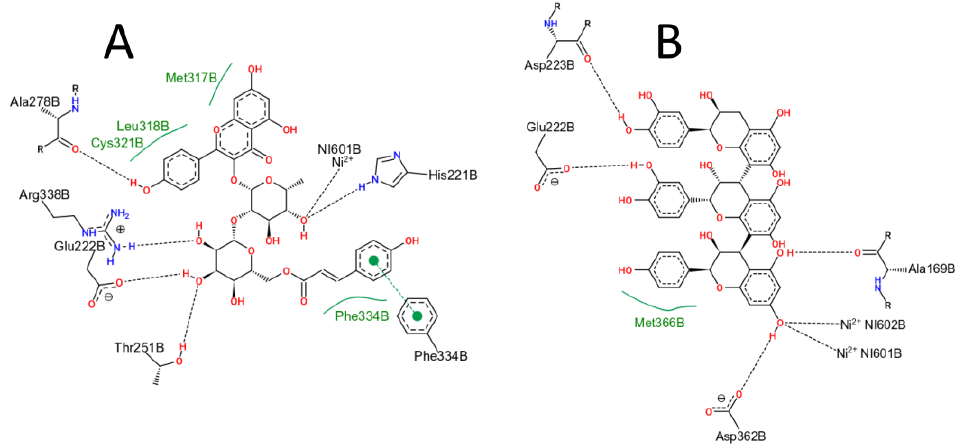
Figure 4. Intermolecular interactions between ligands Kaempferol-3-galactoside-6-rhamnoside-3- rhamnoside, CID44258967 ( A ) and (epi)afzelechin-(epi)catechin-(epi)catechin, AFZ-CAT-CAT ( B ), evaluated by the PoseView program.